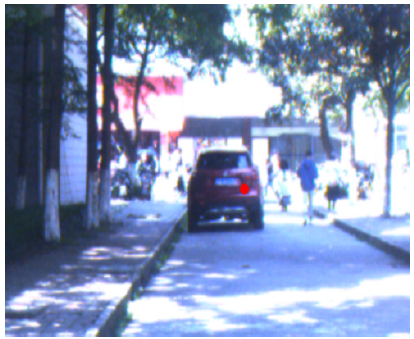
Figure 7. The projected point of the radar’s target detection point in the image.